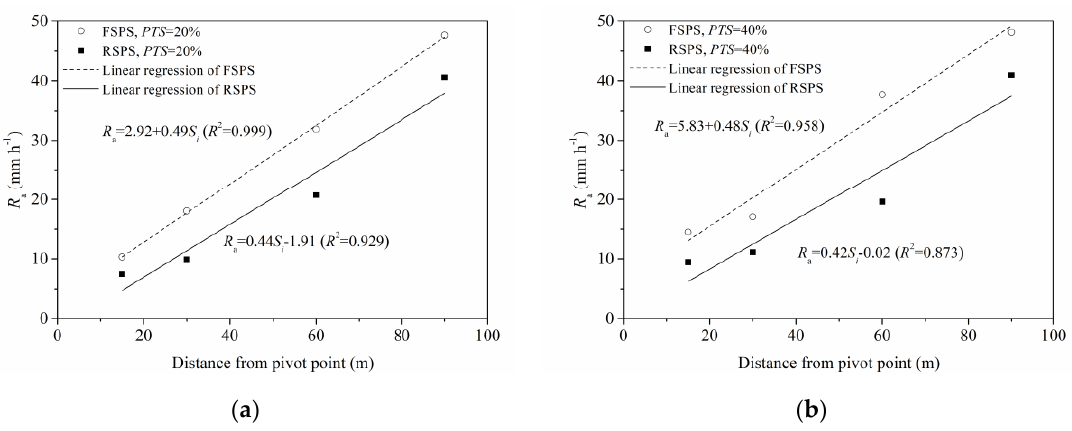
Figure 9. Water application rates at the four radial positions (15, 30, 60, and 90 m) in the center pivot irrigation system with FSPS and RSPS at two travel speeds: ( a ) PTS = 20%; ( b ) PTS = 40%.